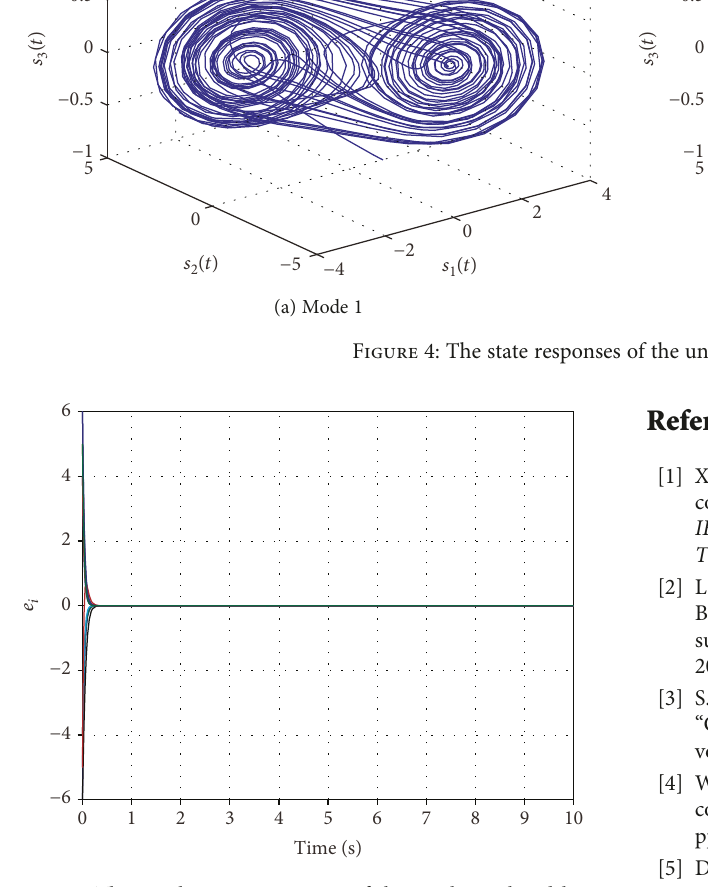
Figure 5: The synchronization errors of the resulting closed-loop